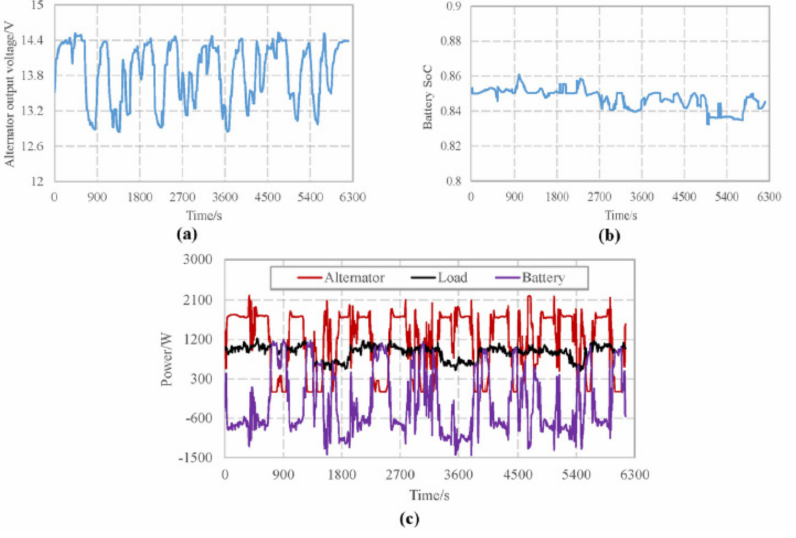
Figure 17. Experimental results using ELP, ( a ) output voltage of the alternator, ( b ) SOC of the battery, and ( c ) change in power contrast [19].